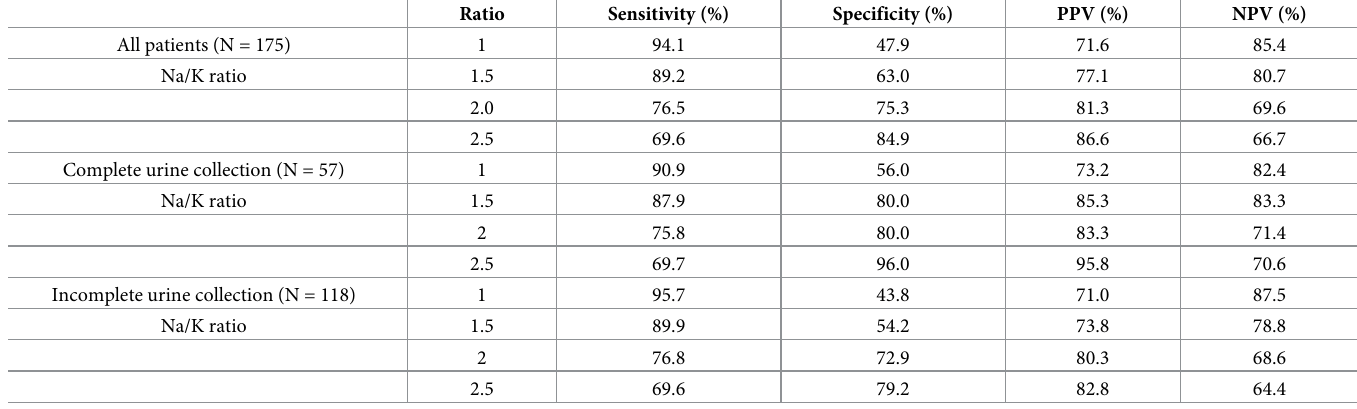
Table 2. Sensitivity and specificity of the different spot urine sodium (Na)/potassium ratios in predicting 24-h urine Na excretion.